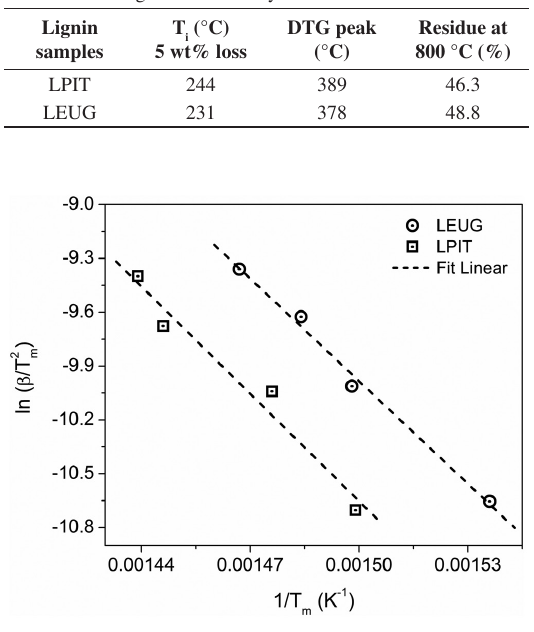
for the lignins studied. m